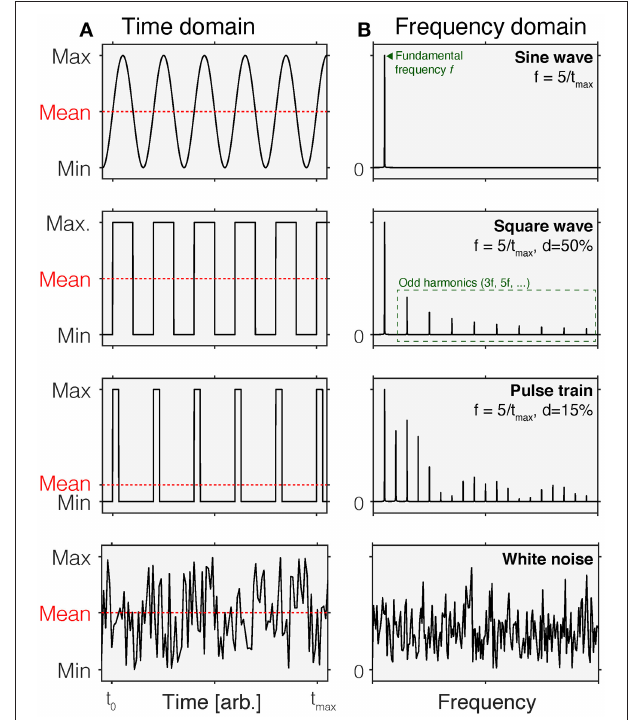
FIGURE 1 | Time-domain (A) and normalized frequency (B) representations of common time-varying stimuli. In each panel in (A) , the mean of each waveform is indicated by the dashed red line. Different waveforms in the time domain have different properties in the frequency domain. Row 1 : A sine wave is a periodic waveform going between minimum and maximum values. It only contains frequency components at the fundamental frequency f . Row 2 : A square wave varies in a discrete fashion between minimum and maximum values. It is composed of sine waves of different frequencies, including the fundamental frequency f and odd harmonics (3f, 5f,…). In a square wave, the duty cycle is 50%, which means that over time, the fraction of time at the maximum value is 50% within a period. Row 3 : A pulse train can be thought of as a square wave with duty cycles that are < 50%. This shorting of the time of that the wave is at maximum introduces additional harmonics. Row 4 : White noise corresponds to a signal that is sampled from a uniform distribution. In the frequency domain, this corresponds to a flat curve, indicating that all frequencies are equally